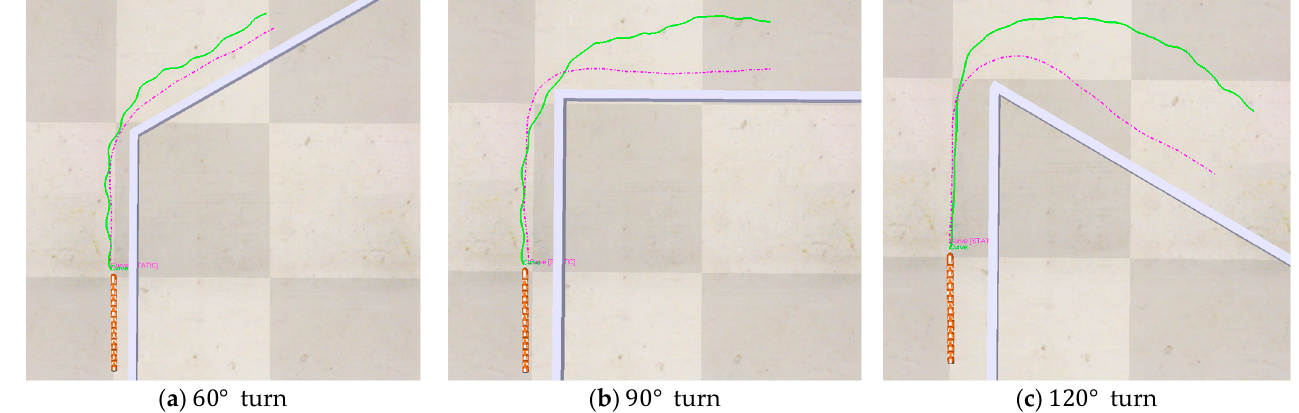
Figure 7. Comparison experiments of double-sine serpentine gait and traditional serpentine gait.